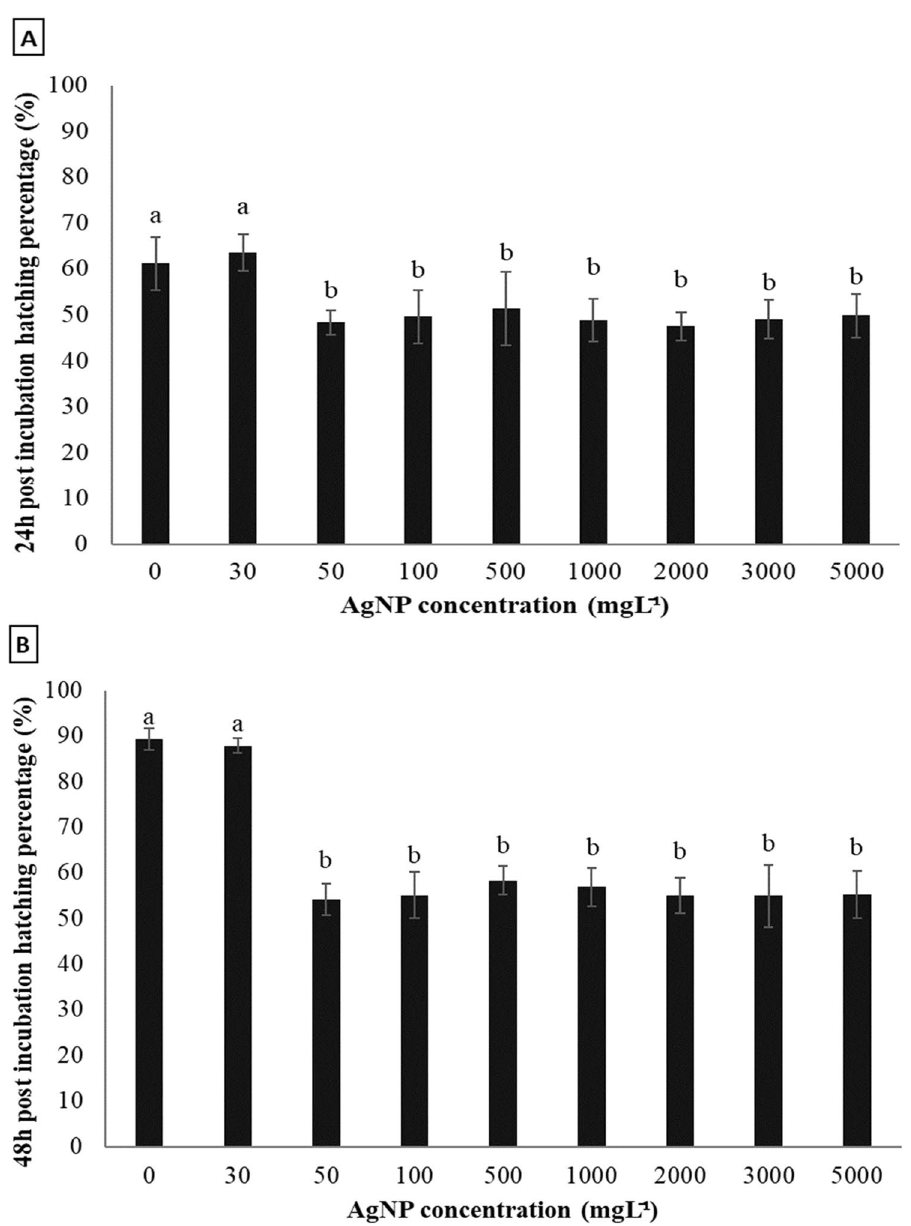
Figure 4. Effect of AgNP concentration on hatching percentage of Artemia cysts incubated on tryptic soy agar for 24 h (a) and 48 h (b) . Values are presented as means ± S.D. (n = 10). The same letters indicate statistically insignificant differences ( p >